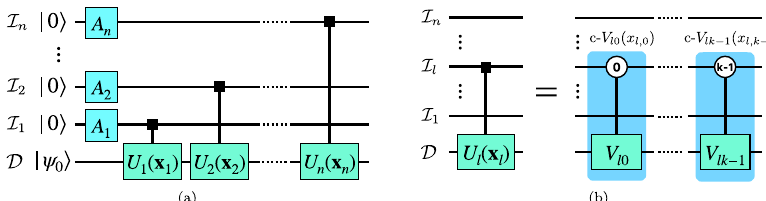
Fig. 1 Circuit design of DSPs with independent increments. a A quantum circuit including preparation of the index system (operators in blue denoted by A l ) and the realization of c − U ( j ) (operators in green denoted by U l ( x ) with a verticle line connected to black squares). A black square is placed on a control register, and the green box denoted by U l ( x ) is placed on a target register. Unlike the conventional symbol for a controlled-NOT gate between qubits, the black square indicates that one of the k different unitary transformations is performed conditioned on the state of the control register of dimension k . b Schematic circuit representation of the applications of c (cid:2) U l 2 B ðH I n as used in ( a ). We use the notation V lj = V ( x l , j ). The open circle with a number j means that the unitary operator V l j is applied if the control register state is j j i